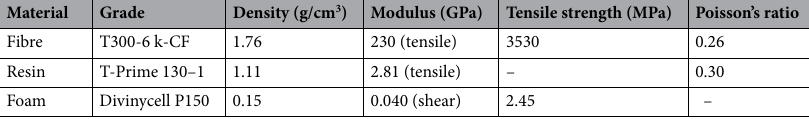
Table 1. Materials’ properties.